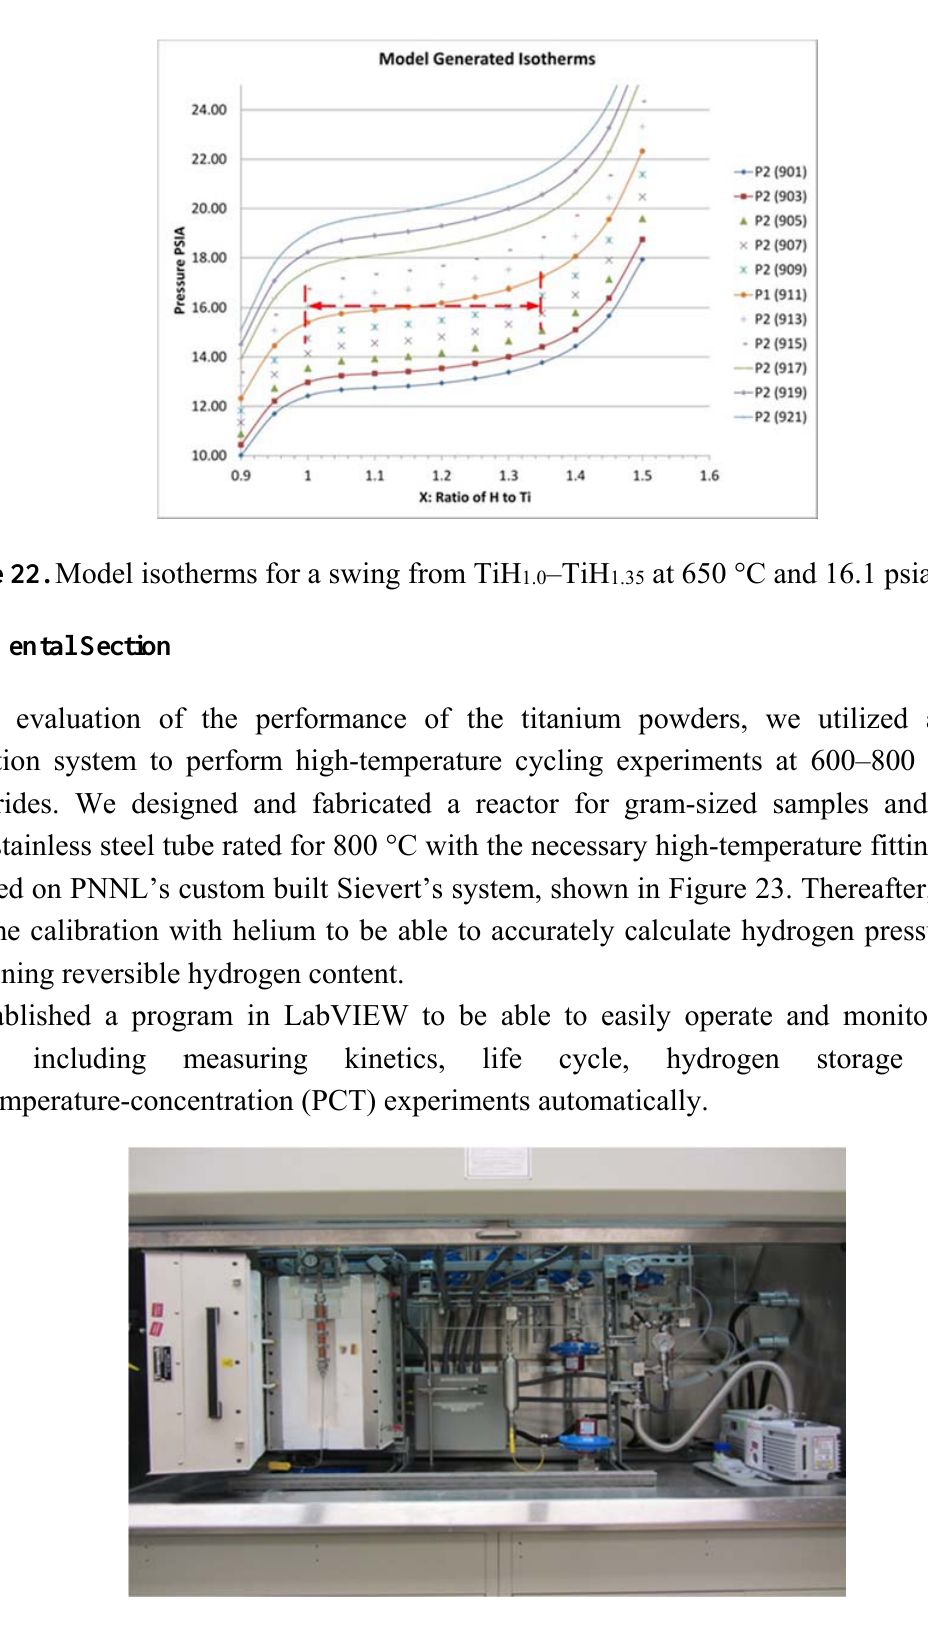
Figure 23. High-temperature reactor installed on PNNL’s Sievert’s system for measuring isotherms and for life cycle testing of metal hydride thermal energy storage